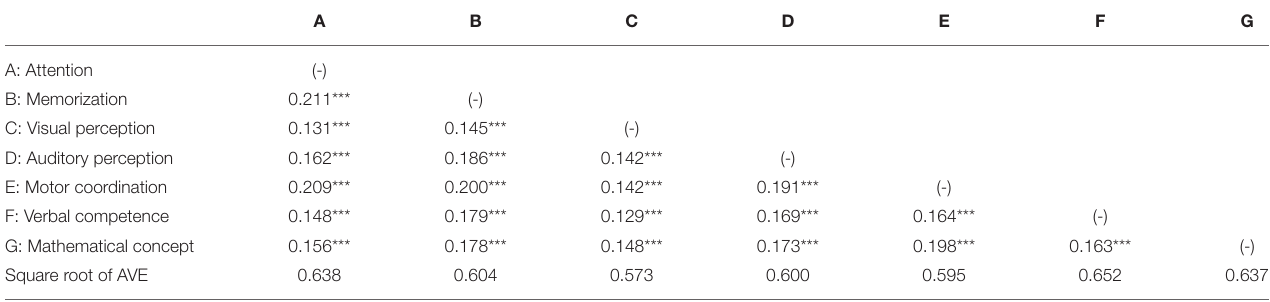
TABLE 6 | Discriminant validity of the preschool learning skills scale ( n = 1,137). A B C D E F G